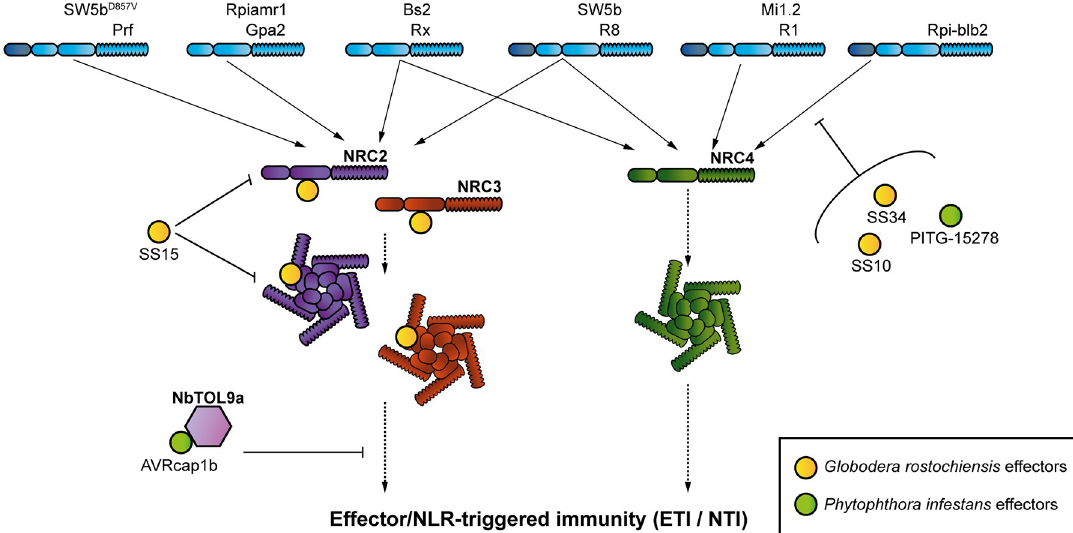
Fig 14. Evolutionary divergent pathogens have evolved to target multiple layers of the Solanaceae NLR network. P . infestans and G . rostochiensis , 2 evolutionary distinct pathogens, have evolved effectors that suppress signalling mediated by the NRC network. Two effectors from the cyst nematode pathogen, G . rostochiensis (SS10 and SS34), and 1 effector from the blight pathogen, P . infestans (PITG- 15278) suppress the function of the NRC4-dependent sensor NLR, Rpi-blb2. The cyst nematode effector, SS15, binds to the NB-ARC domain of both inactive and activated forms of NRC2 and NRC3. By binding the NB-ARC domain of NRC2 and NRC3, SS15 is able to suppress their function. The P . infestans effector, AVRcap1b, suppresses the function of NRC2 and NRC3, and in the case of NRC3, AVRcap1b suppression requires the ESCRT-related protein NbTOL9a. ESCRT, endosomal sorting complex required for transport; ETI/ NTI, effector/NLR-triggered immunity; NB-ARC, nucleotide-binding domain shared with APAF-1, various R-proteins, and CED-4; NLR, nucleotide-binding domain and leucine-rich repeat; NRC, NLR required for cell death.